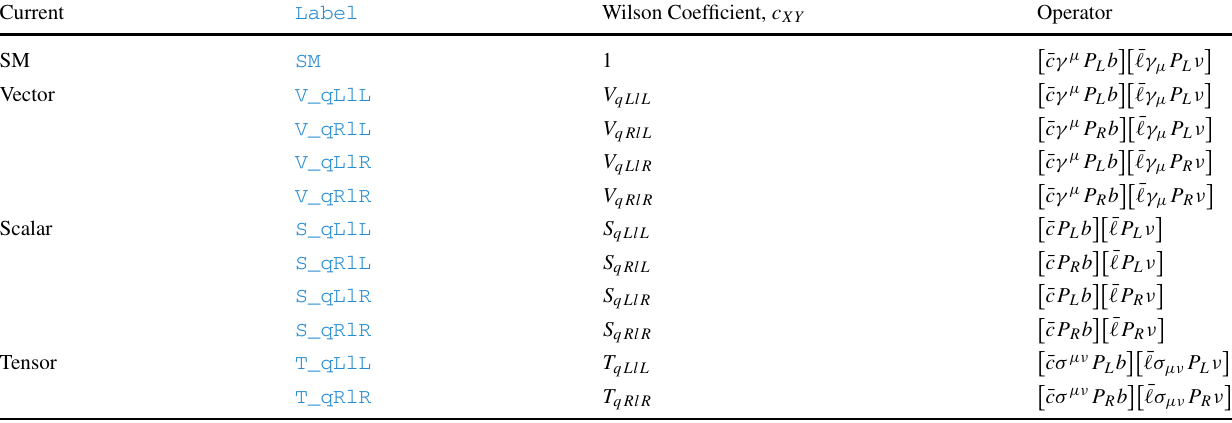
Table 2 The Asimov data set components. The fractions were motivated by Refs. [1,24]